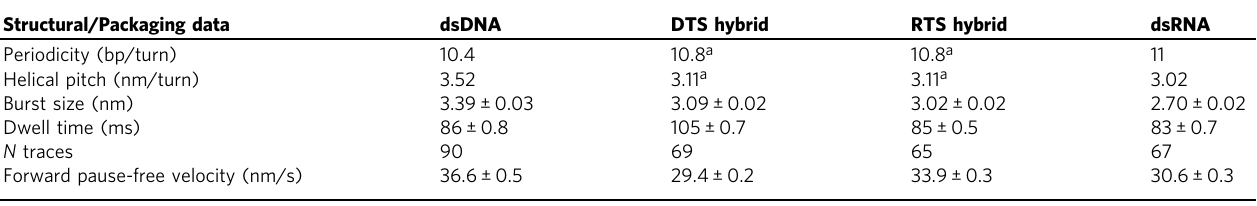
Table 1 Structural and packaging features of the four different